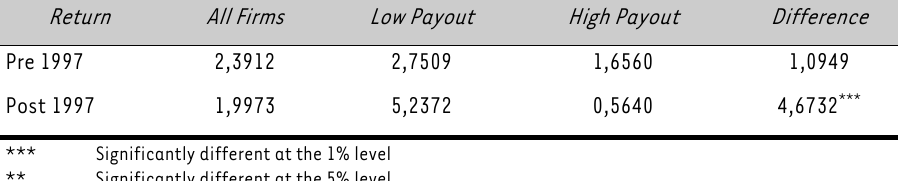
TABLE 7: Long-run returns for high and low payout